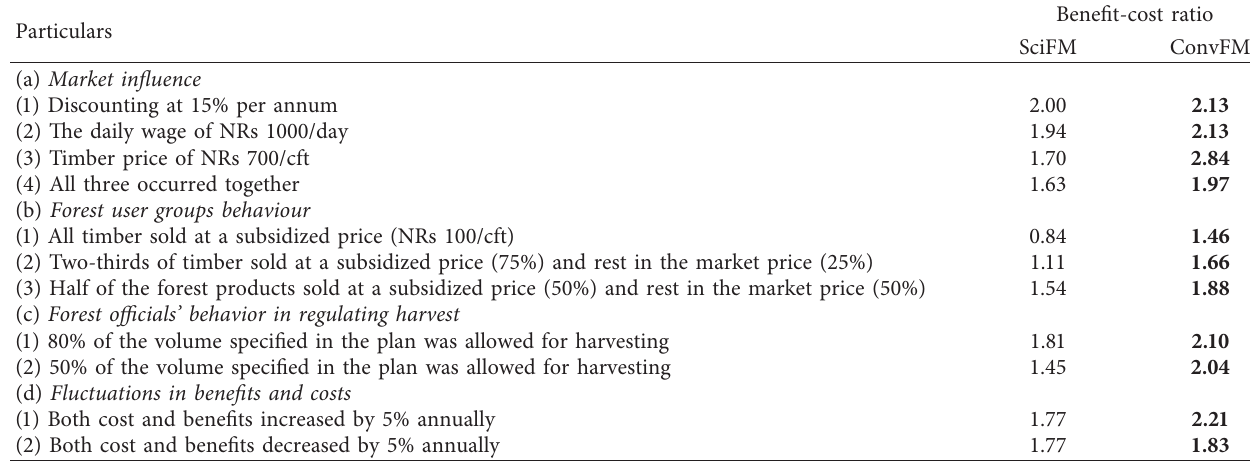
Table 8: Sensitivity analysis of two forest management